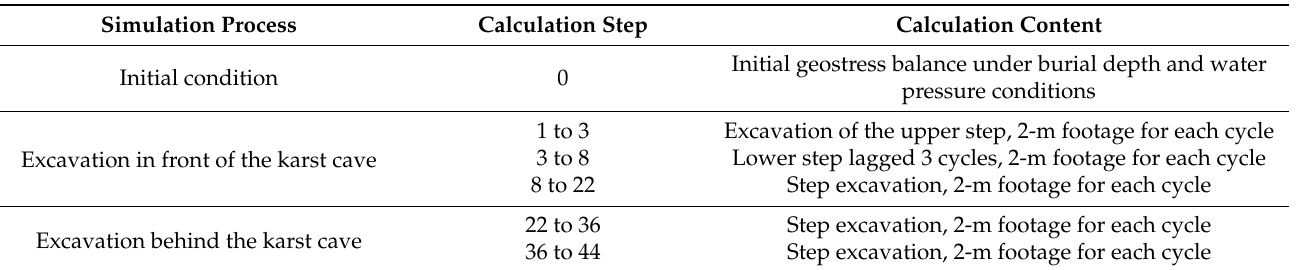
Figure 6. Schematic diagram of tunnel excavation. Table 2. Excavation simulation